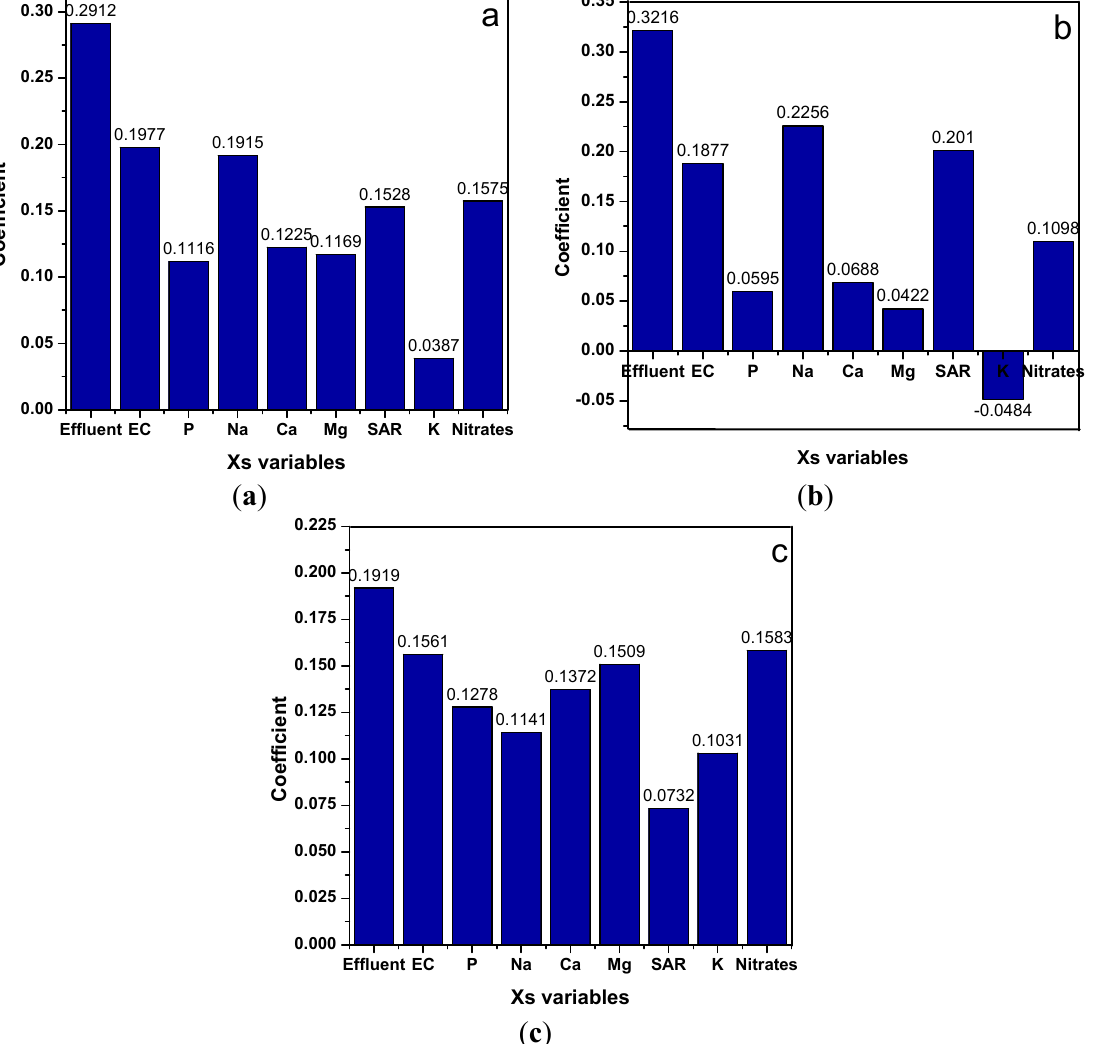
Figure 3. Coefficients of the Xs in the PLSR regression for the models of: ( a ) plant biomass; ( b ) N uptake; and ( c ) P uptake, based on the centered and scaled